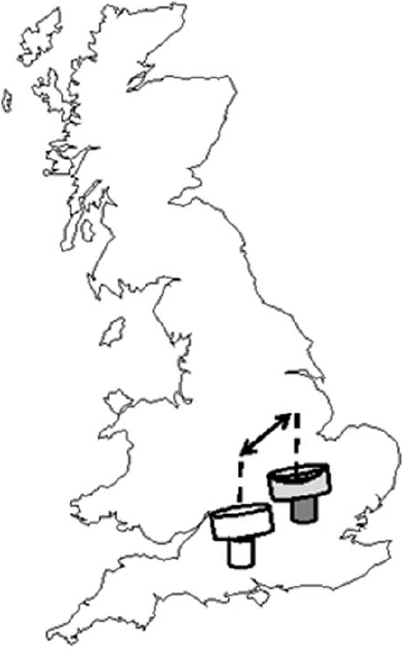
Figure 1. Location of the vertical-looking radars. The radars at Rothamsted, Hertfordshire (shaded) and Chilbolton, Hampshire (white- filled) are shown. The arrow indicates that the Euclidean distance between the sites is 104